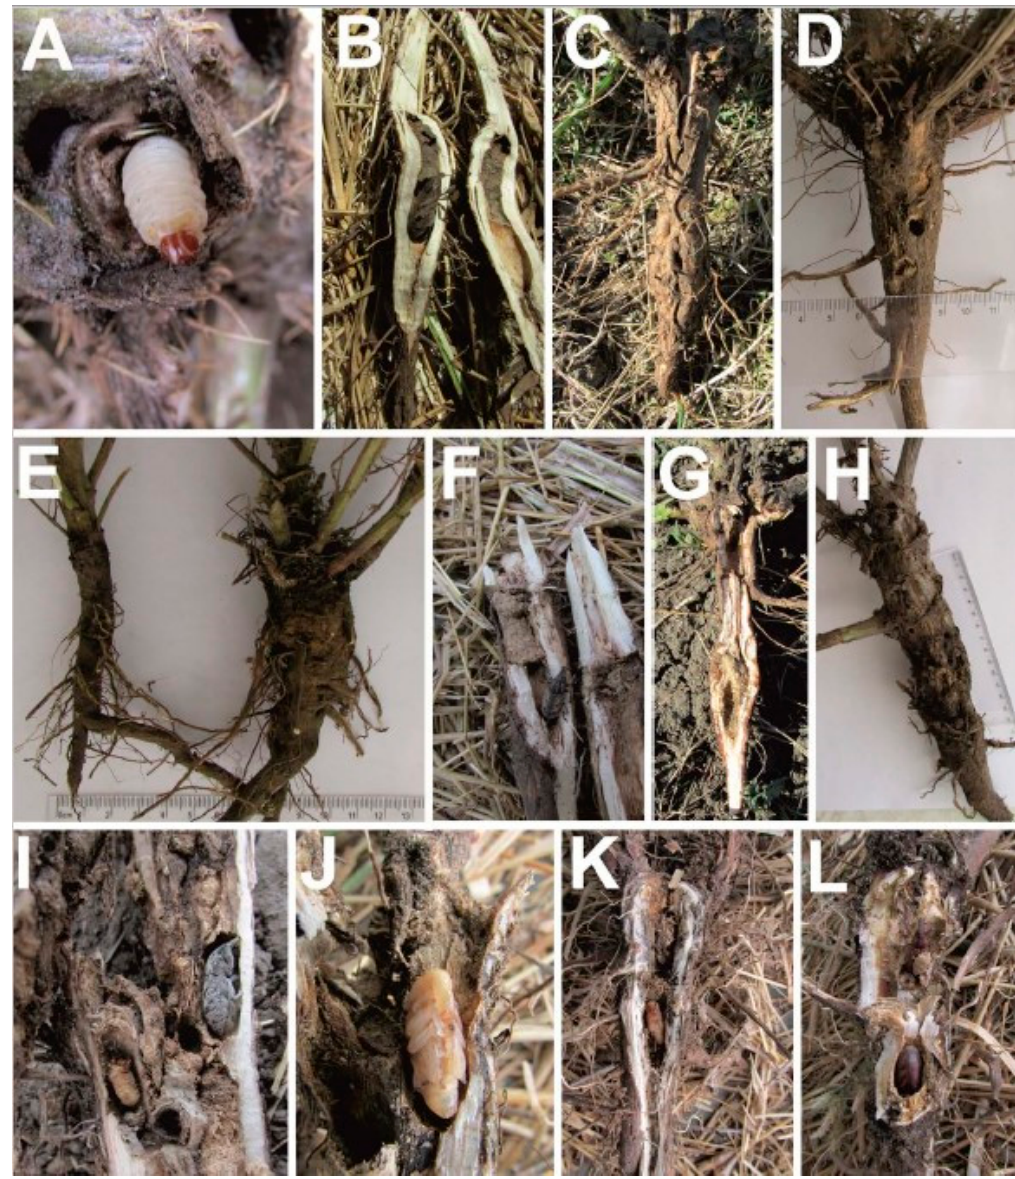
Figure 6. Cleonis pigra life history. ( A )—mature larva in the root crown of Cirsium ukranicum ; ( B )—the curved tunnel, pupa chamber and adult; ( C )—root gall of C. ukranicum ; ( D )—normal root of Centaurea diffusa (left) and gall on the same plant; ( E )—root gall on C. ukranicum ; ( F )—adult in the larval chamber with cork above the chamber; ( G )—larval tunnel and pupal chamber on C. ukranicum ; ( H )—a compound gall on C. ukranicum ; ( I )—adult and dead larva in a gall; ( J )—young pupa of Cleonis pigra ; ( K )—pupa begins to sclerotize from its eyes and rostrum; ( L )—occasionally, pupa and adult may be located head down. All photos: S. Volovnik.